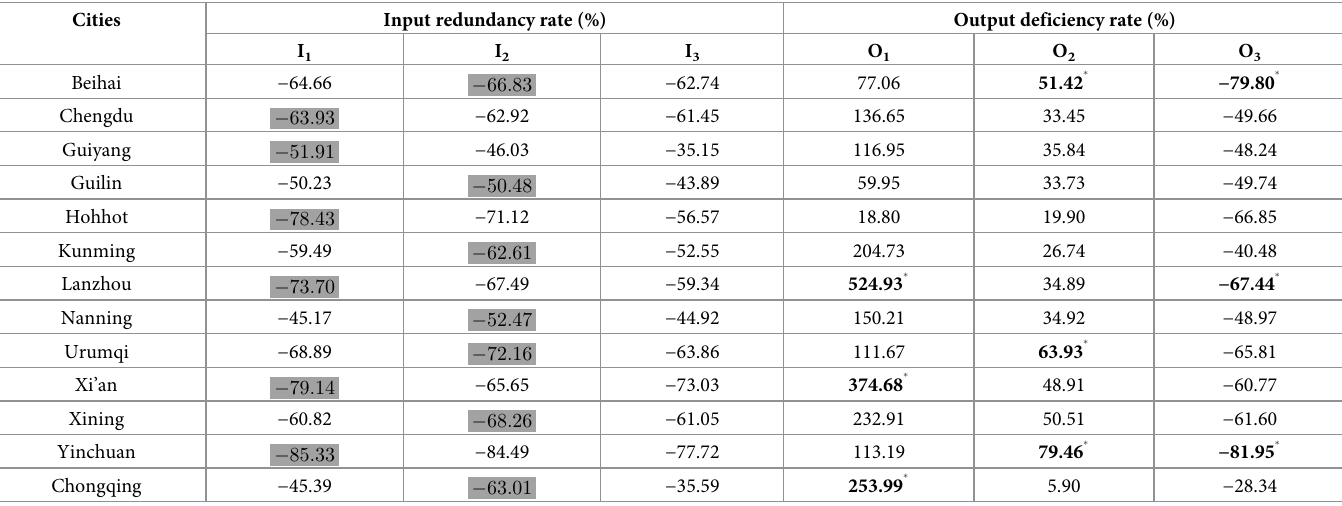
Table 2. Input–output optimisation result of tourism development in the main western cities.